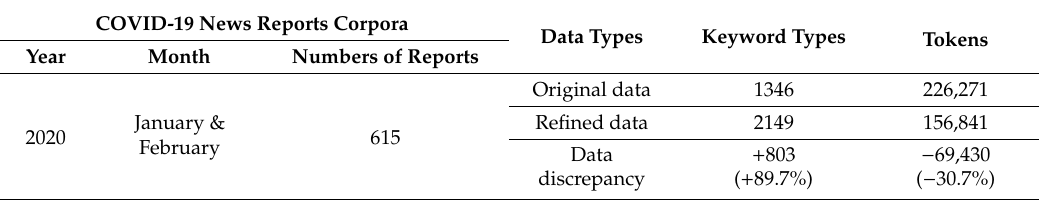
Table 9. Comparison of original and refined data of the “keyword